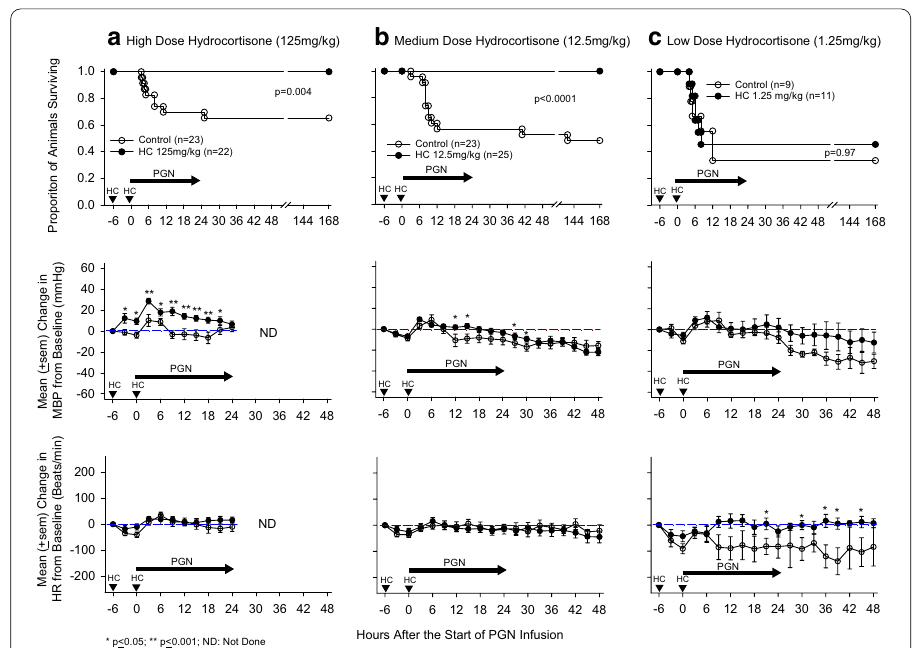
Fig. 1 This figure compares proportional survival and mean ( sem) serial changes in mean arterial ± blood pressure (MBP) and heart rate (HR) during and after a 24-h B. anthracis peptidoglycan infusion (PGN, horizontal arrows) in diluent (control) treated animals versus animals treated with either a high (125 mg/kg) ( a ), medium (12.5 mg/kg) ( b ) or low (1.25 mg/kg) ( c ) dose of hydrocortisone (HC). Hydrocortisone or diluent treatment were administered intravenously 6 h before and at the start of PGN infusion (inverted dark arrow heads). Survival is shown from the start of PGN and serial changes in MBP and HR were measured and shown from 6 h before until either 24 h (high-dose HC) or 48 h (medium and low-dose HC) after the start of